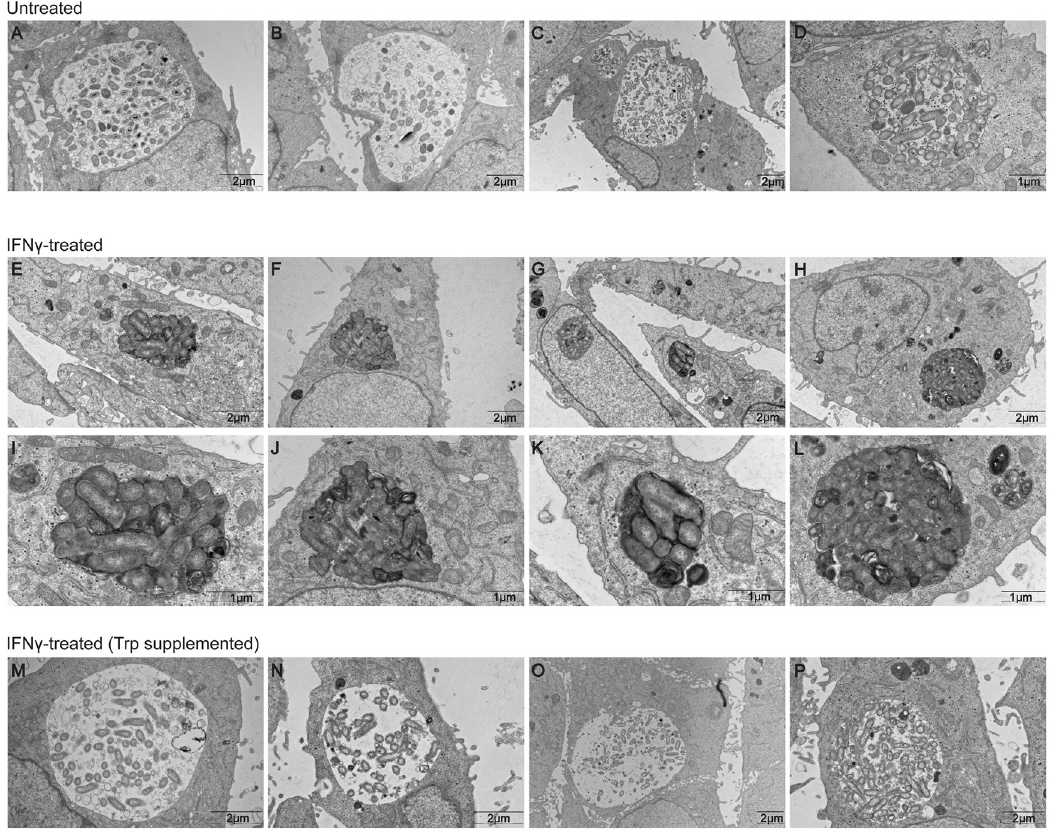
Fig 5. IDO1-mediated depletion of tryptophan interferes with the size and morphology of the CCV. C . burnetii -infected cells were left untreated or treated with IFN γ in the presence or absence of tryptophan as per the experimental layout in Fig 4A. Representative TEM images from untreated (A-D), IFN γ -treated (E-L) and tryptophan supplemented, IFN γ -treated (M-P) cells on d4 pi are presented here. I, J, K and L are higher magnification images of E, F, G and H respectively. Scale bars are denoted at the bottom right of each